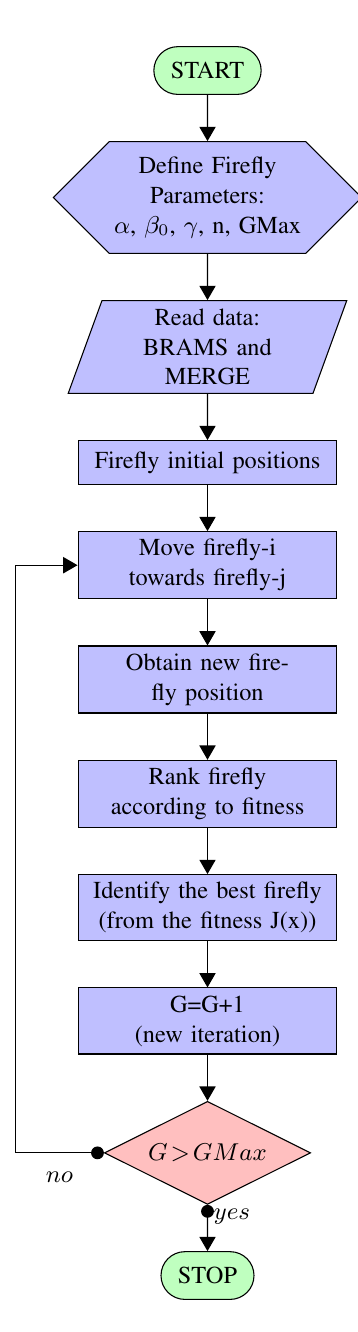
Fig. 1. The firefly algorithm implemented.